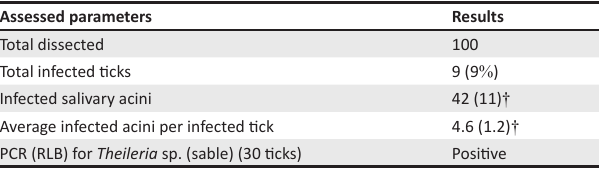
TABLE 3: Methyl-green and pyronin tick salivary gland staining and polymerase chain reaction. Infection rate in adult Rhipicephalus appendiculatus ticks collected from grass.